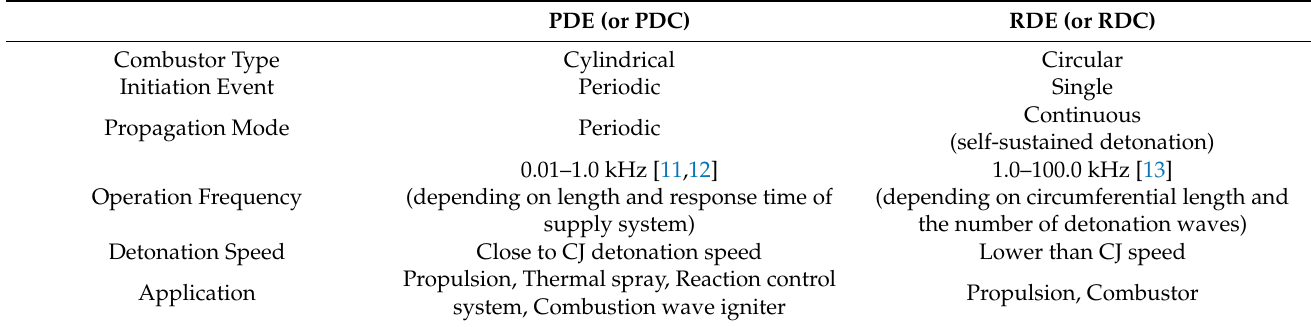
Table 1. Comparison of the typical characteristics of rotating detonation engines (RDEs) and Pulse detonation engines (PDEs).